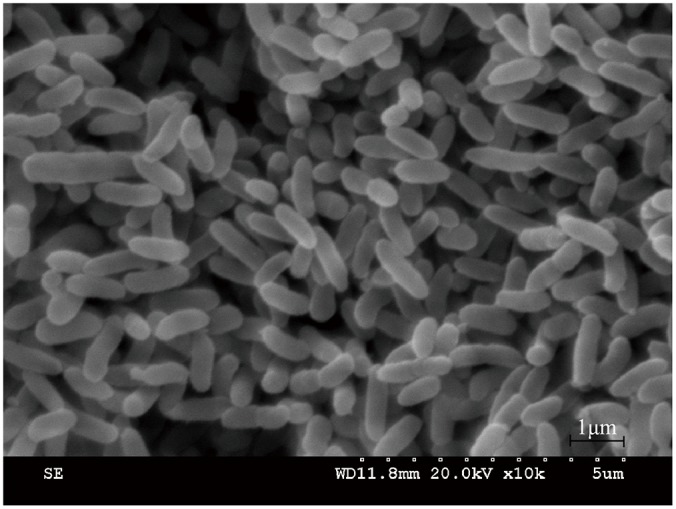
SEM image of HC3 at 10000 × magnification.